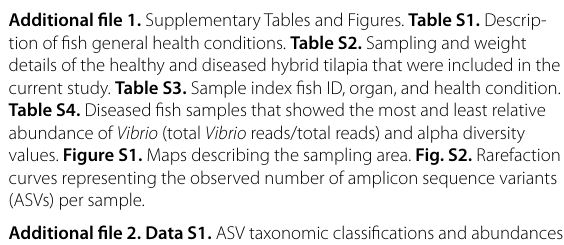
Table S4. Diseased fish samples that showed the most and least relative abundance of Vibrio (total Vibrio reads/total reads) and alpha diversity values. Figure S1. Maps describing the sampling area. Fig. S2. Rarefaction curves representing the observed number of amplicon sequence variants (ASVs) per